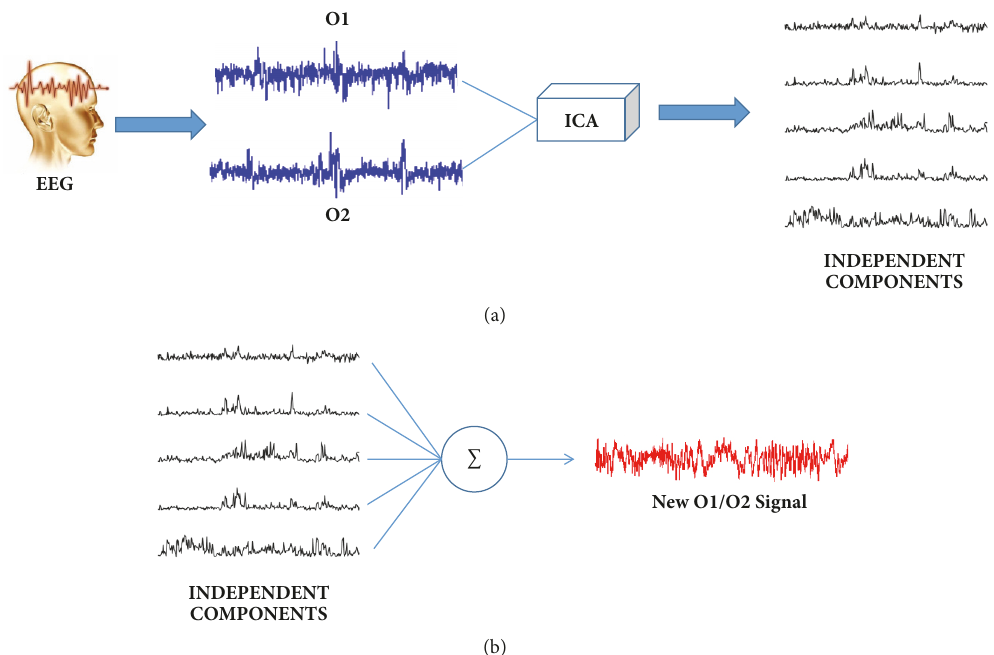
Figure 8: ICA model. (a) Independent components obtained from the mixture of signals O1 and O2. (b) Signal reconstructed from the combination of independent